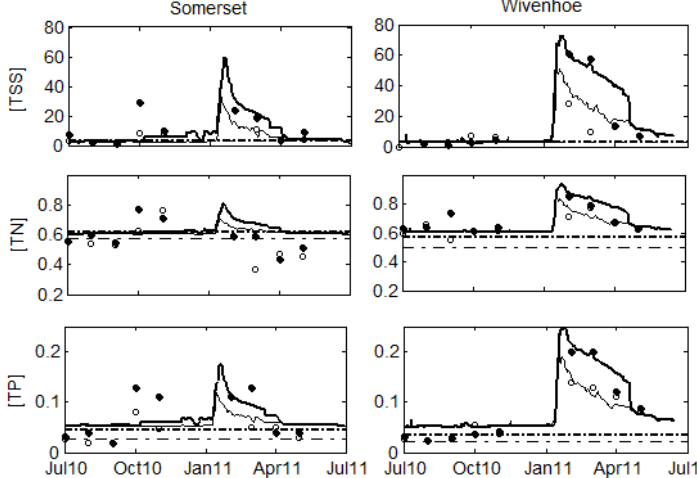
Figure 7. [TSS], [TN] and [TP] (in mgL − 1 ) at dam outlets measured during monthly monitoring (round symbols), calculated from the daily measured turbidity profile (solid lines) and mean historical concentrations (broken lines). Surface concentrations are denoted by open circles and thin lines, bottom readings are closed circles and heavy lines. Note that TSS mean is from log-transformed data. Table 2. Retention of water, TSS, TN and TP in Somerset and Wivenhoe reservoirs from June 1997 to July 2011. Water year 2010 is the flood year. S: Somerset reservoir, W: Wivenhoe